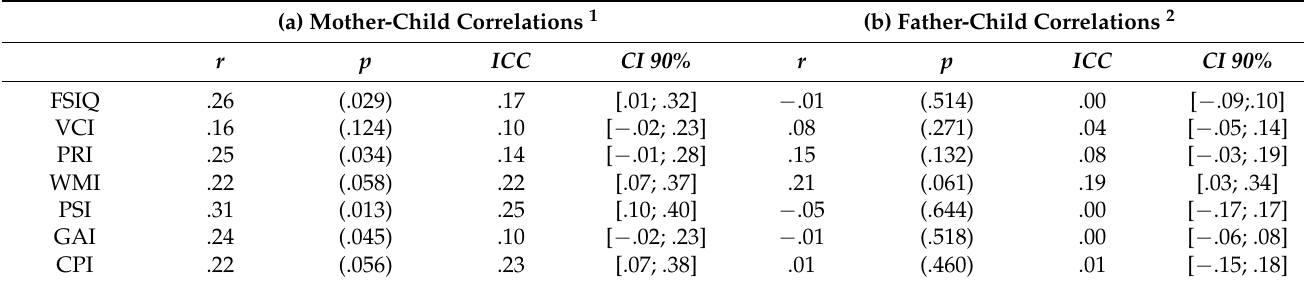
Table 7. Pairwise correlations between parent WAIS-IV scores and child WISC-IV scores.